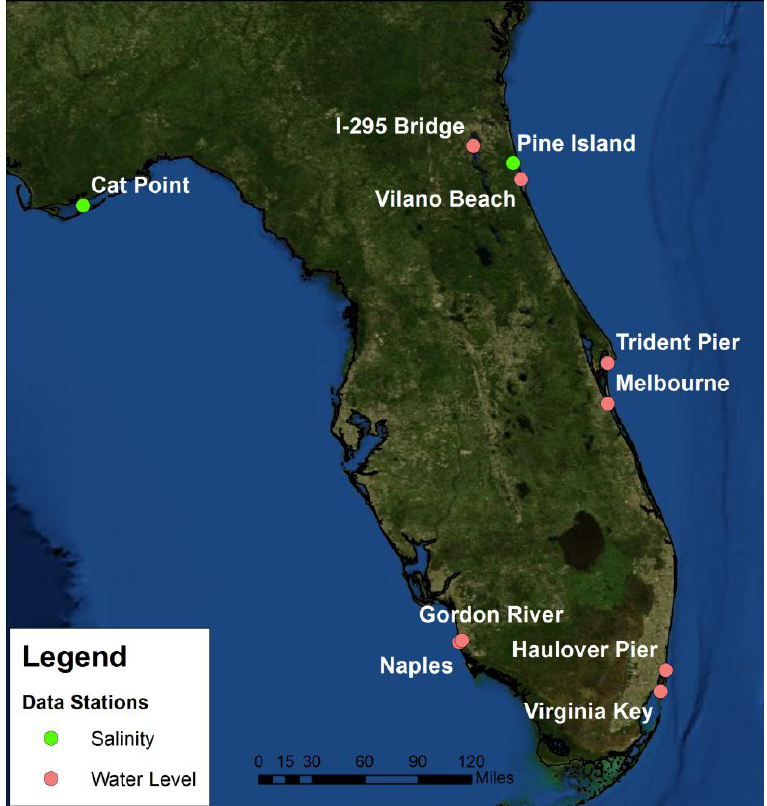
Figure 4. Location of select data stations used for ACMS validation.